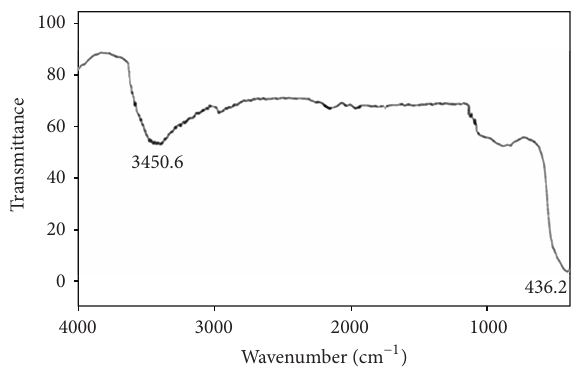
F 5: FT-IR spectrum of zinc oxide